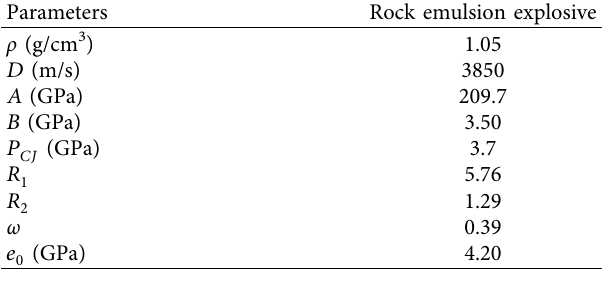
Figure 2: Geometry models of the cylindrical and spherical explosive simulation. Table 1: Material parameters for rock emulsion